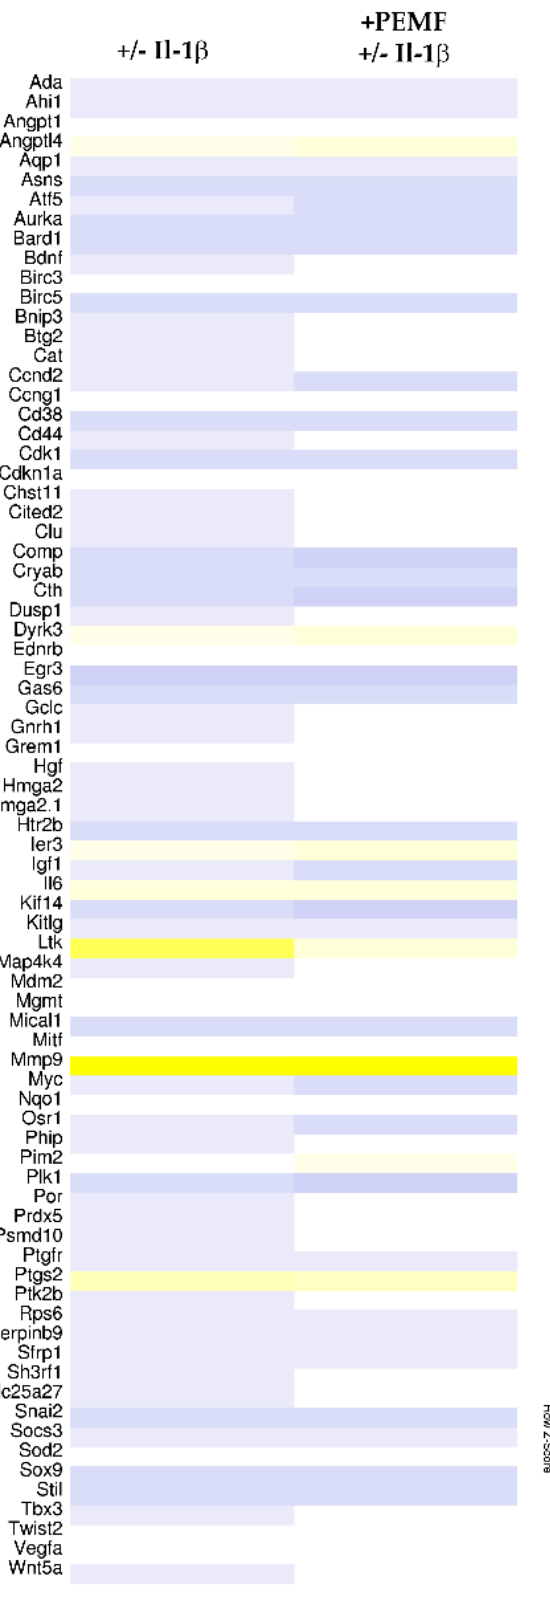
Figure 5. Heatmap of differentially expressed genes identified for the 2 paired groups ([ − /+ Il-1 β ] and [ + PEMF − /+ Il-1 β ]) assigned to the GO term “negative regulation of apoptotic process” ( ≥ 2.0 fold change; p value < 0.05).